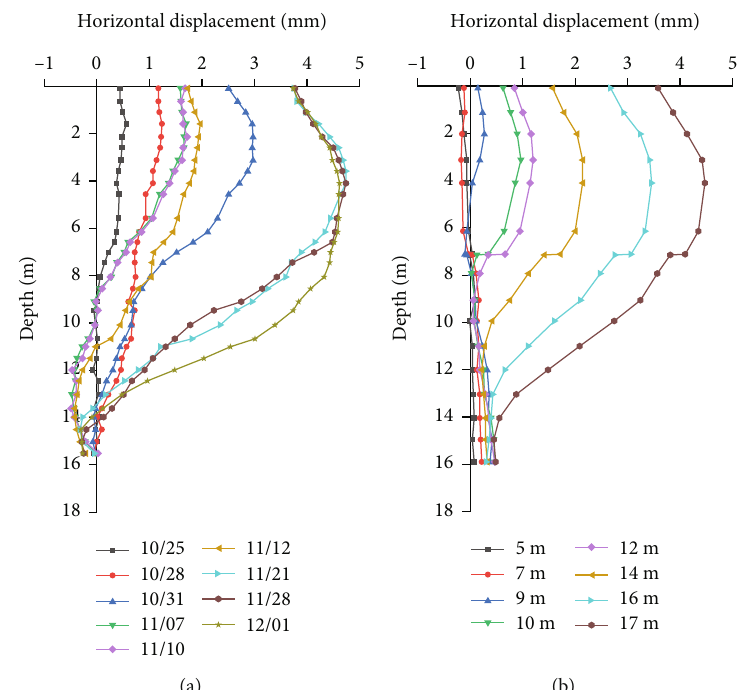
Figure 7: Measured and simulated curves of foundation pit. (a) Horizontal displacement of piles monitored on the west side of foundation pit. (b) Horizontal displacement of simulated body of foundation pit.